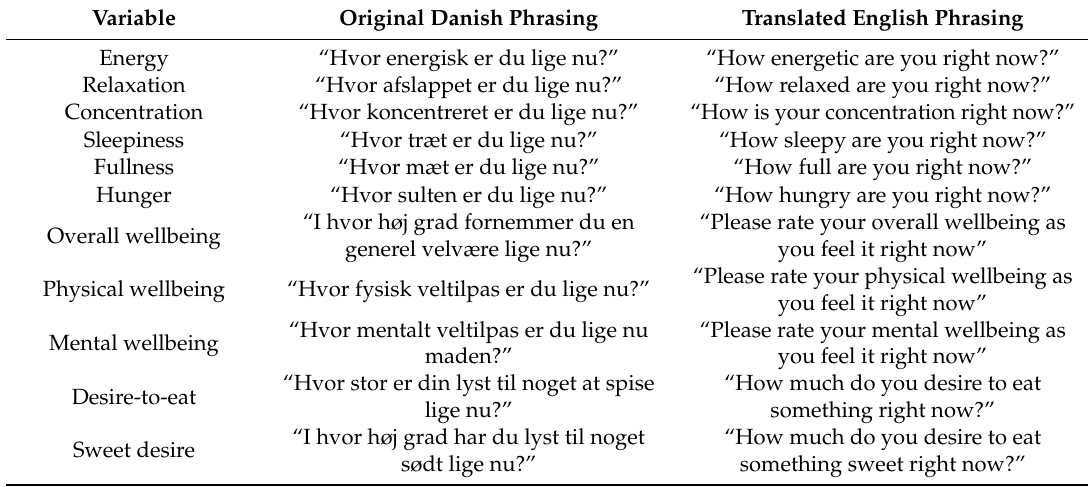
Table A1. Response variables with their original Danish phrasing a well as the English